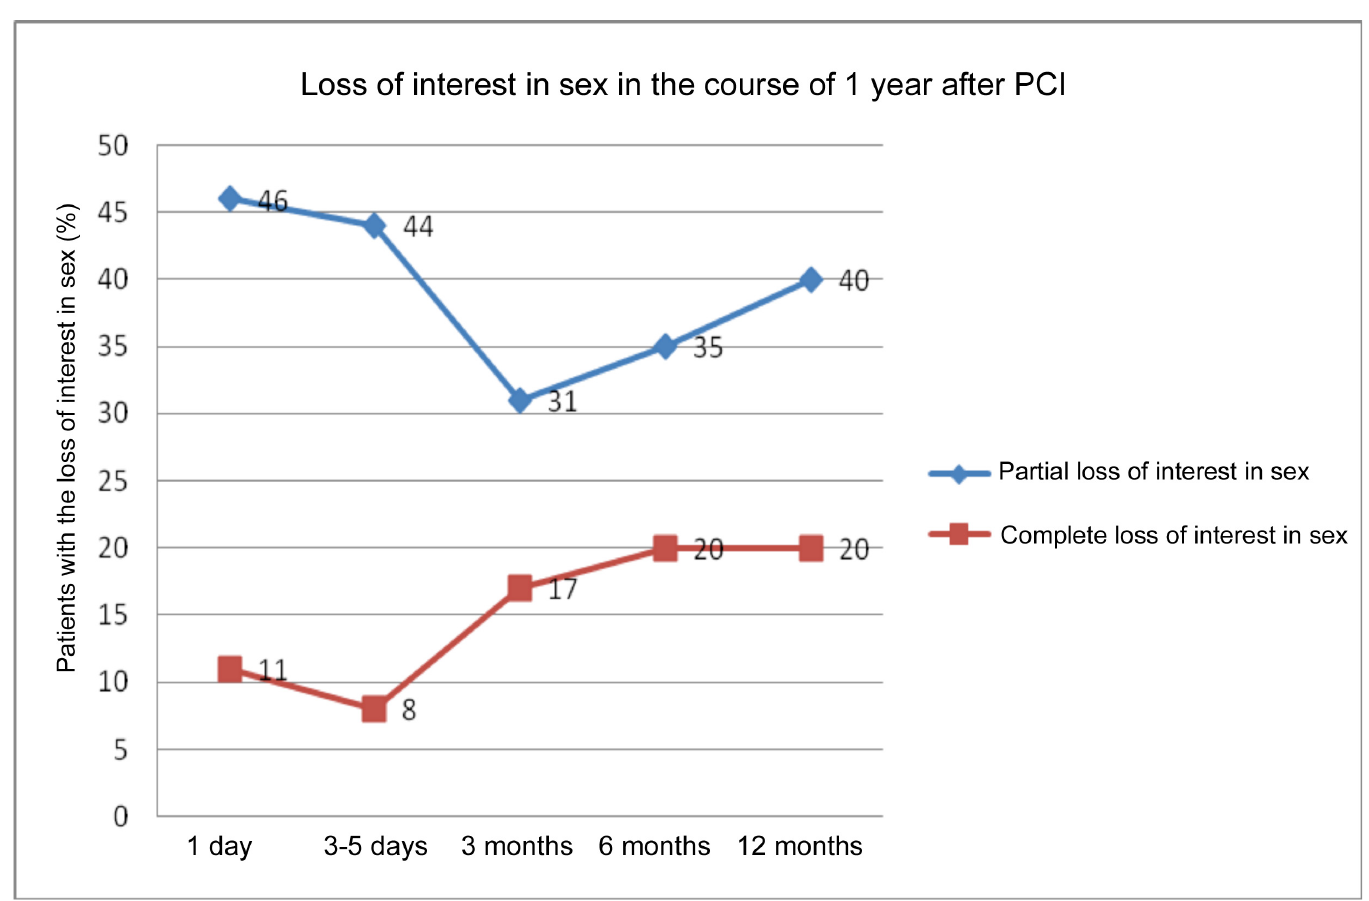
Fig 3. Loss of interest in sex in the course of 1 year after